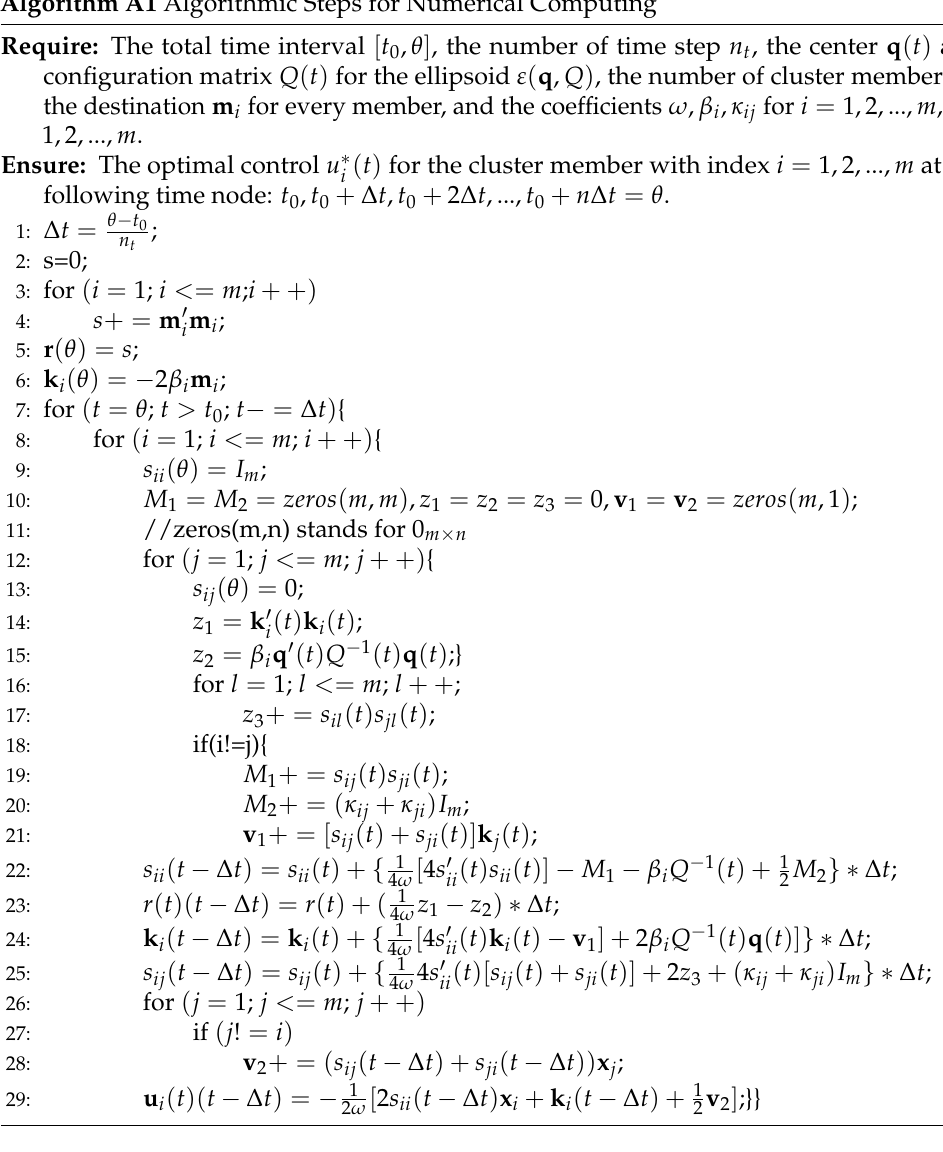
Algorithm A1 Algorithmic Steps for Numerical